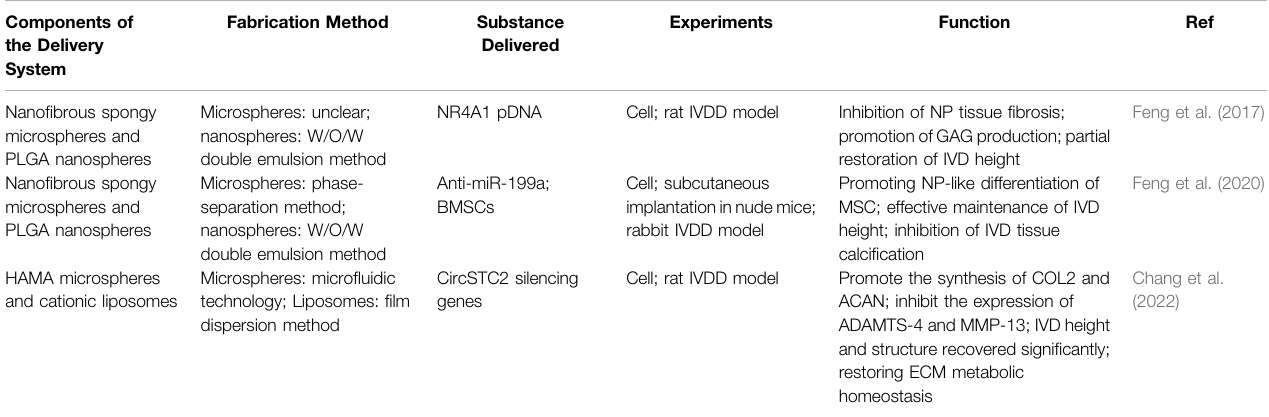
TABLE 2 | ( Continued ) Application of microsphere-based delivery systems in